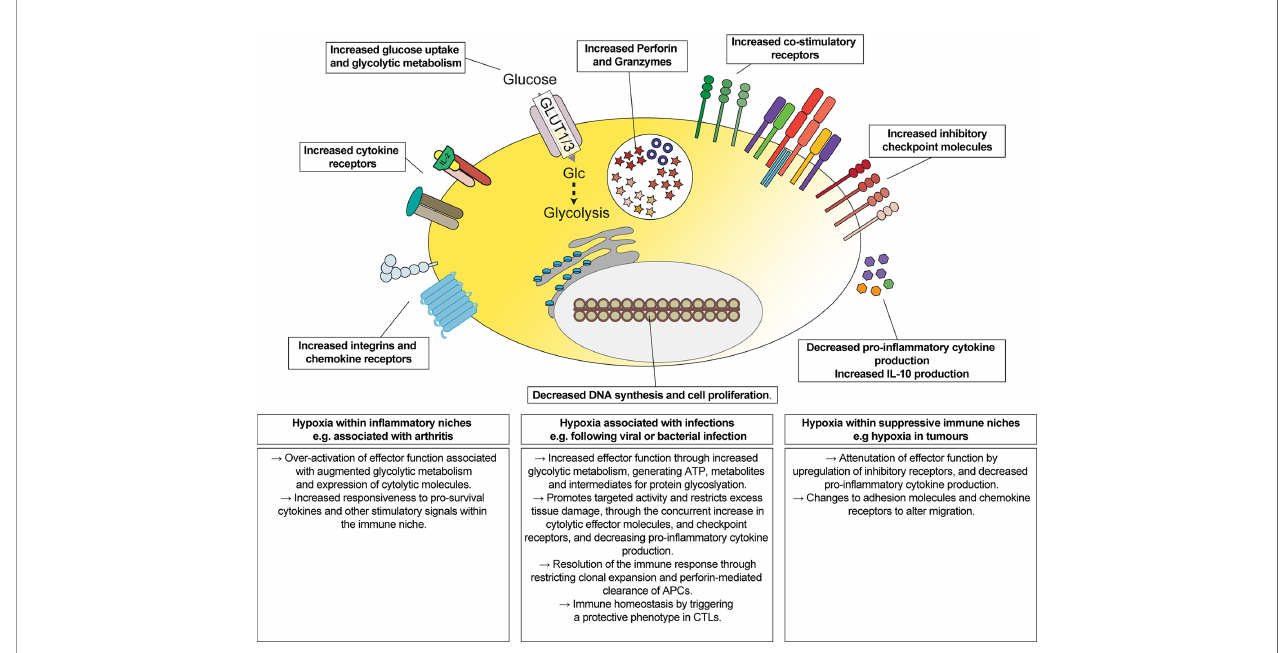
FIGURE 7 | Overview of the impact of hypoxia on CTLs. Schematic representation of changes induced by hypoxia on CTLs, and their implications for regulating the function of CTLs in different immune